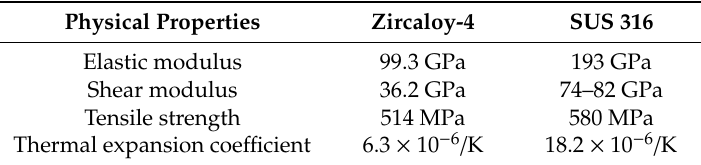
Table 1. Physical properties of Zircaloy-4 and stainless use steel (SUS) 316.